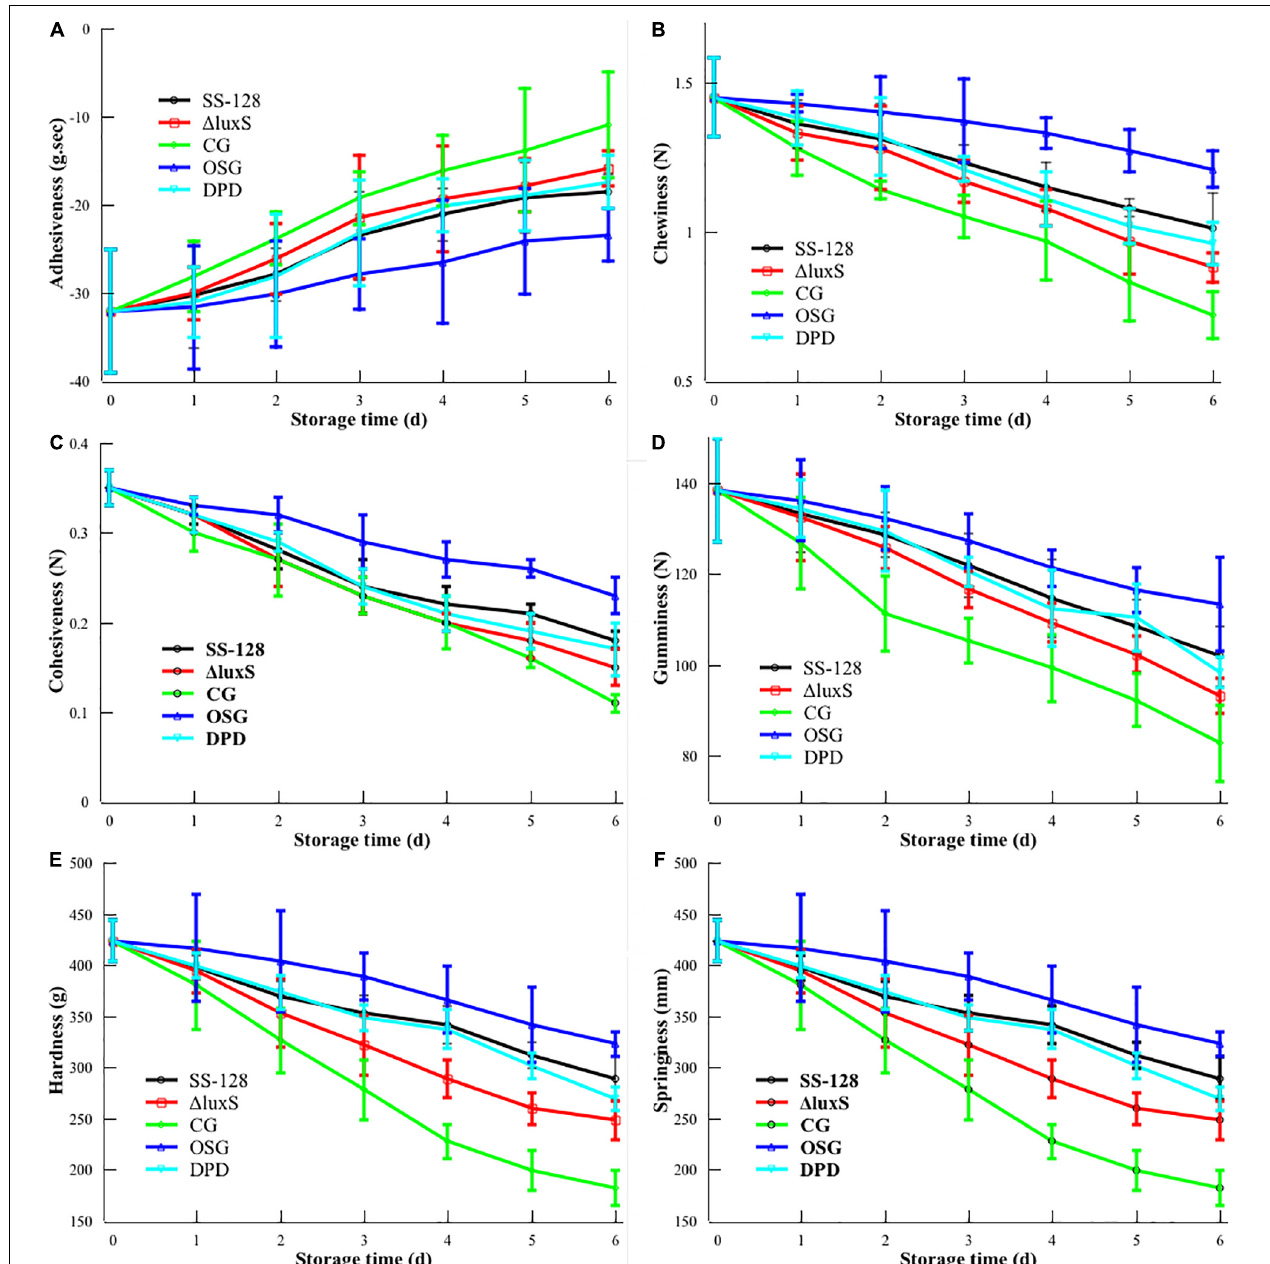
FIGURE 2 | Texture changes during storage of Litopenaeus vannamei . (A) Adhesiveness; (B) chewiness; (C) cohesiveness; (D) gumminess; (E) hardness; and (F)